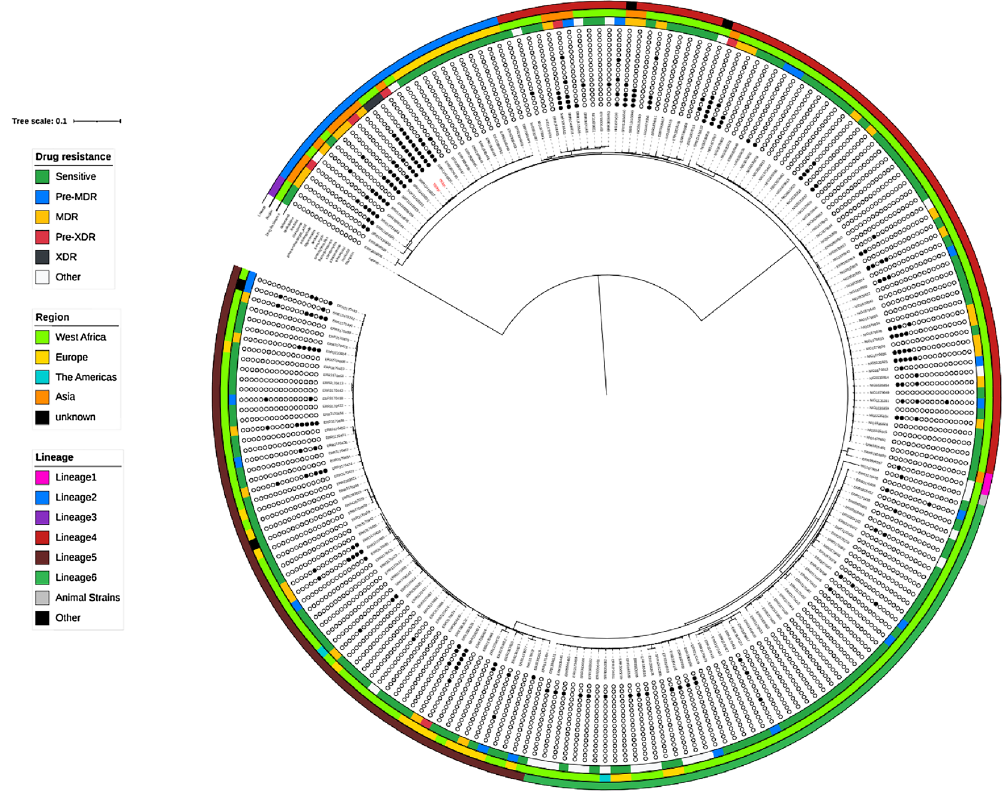
Figure 1. Maximum likelihood phylogeny tree of MTBC samples inferred from their core genomes with lineage classification, region where samples were collected and drug resistance profile. The samples coloured red are genomes generated from this